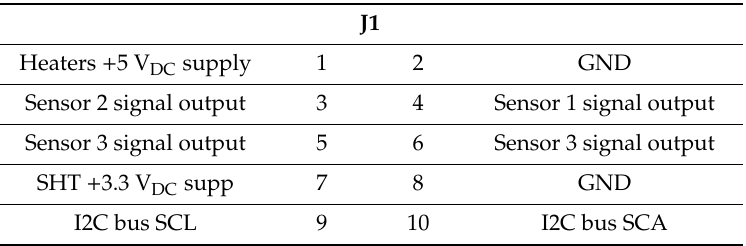
Table 1. List of the signals routed through the mother–daughter board the pin-header connector. Sensor signals are arranged to provide shielding from the digital bus by putting the power supply lines in-between.